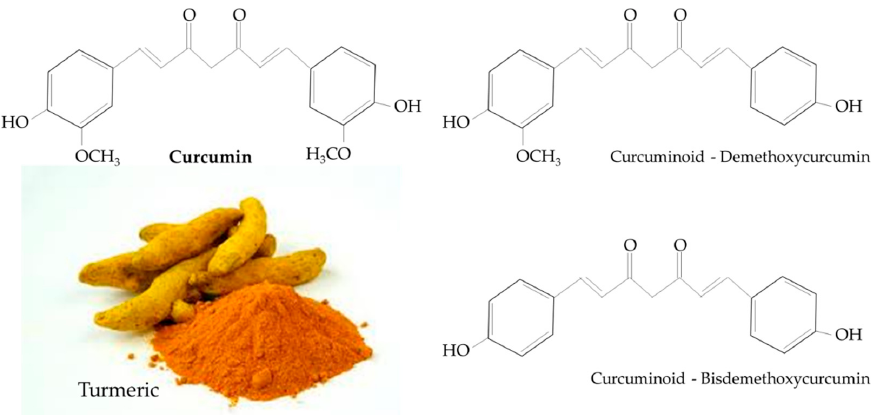
Figure 1. Chemical structure of curcumin and curcuminoids found in turmeric.